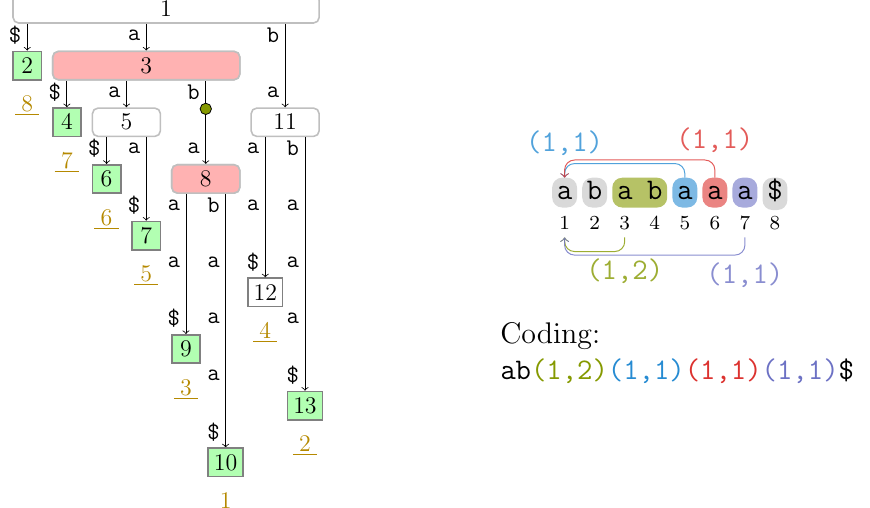
Figure 2. ( Left ) Suffix tree of the text T = ababaaa$ with the witness nodes and the corresponding leaves of the non-overlapping LZSS factorization highlight in red ( ) and in green ( ), respectively. We additionally mark the string ab with an implicit node ( ) whose string label is equal to the factor with Type 3. The nodes are labeled by their preorder numbers. The suffix number of each leaf λ is the underlined number drawn in dark yellow below λ . ( Right ) Non-overlapping LZSS factorization of T